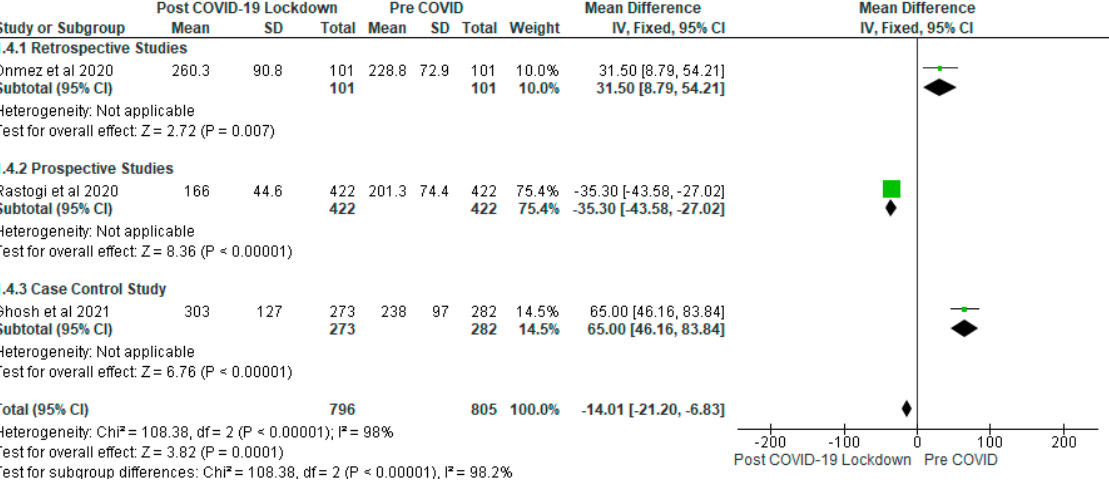
13 of 20 Figure 4. The effect of COVID-19 lockdown on Fasting Plasma Glucose (mg/dL). In contrast, the results of the meta-analysis of postprandial blood glucose showed that post-COVID-19 lockdown gp had significantly ( p < 0.05) reduced postprandial blood glucose (mg/dL) compared with the pre-COVID gp (Fig- ure 5) with a mean difference of − 14.01 (95% CI: − 21. 20, − 6.83) (Figure 5). Fol- lowing sensitivity analysis, the result remained consistent except when Rastogi et al. [28] study was removed from the meta-analysis that the post- COVID-19 gp showed significantly ( p < 0.05) higher postprandial blood glu- cose than the pre-COVID gp. Only three studies contributed to the analysis